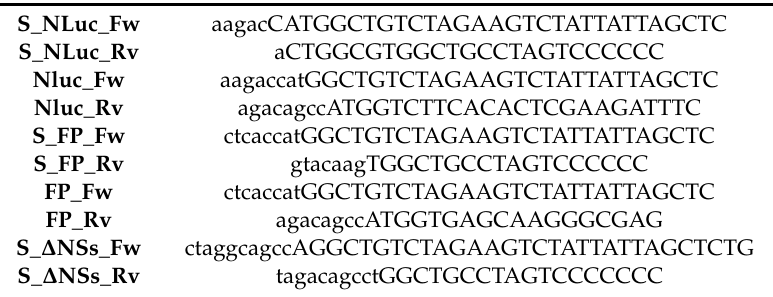
Table A5. Primer